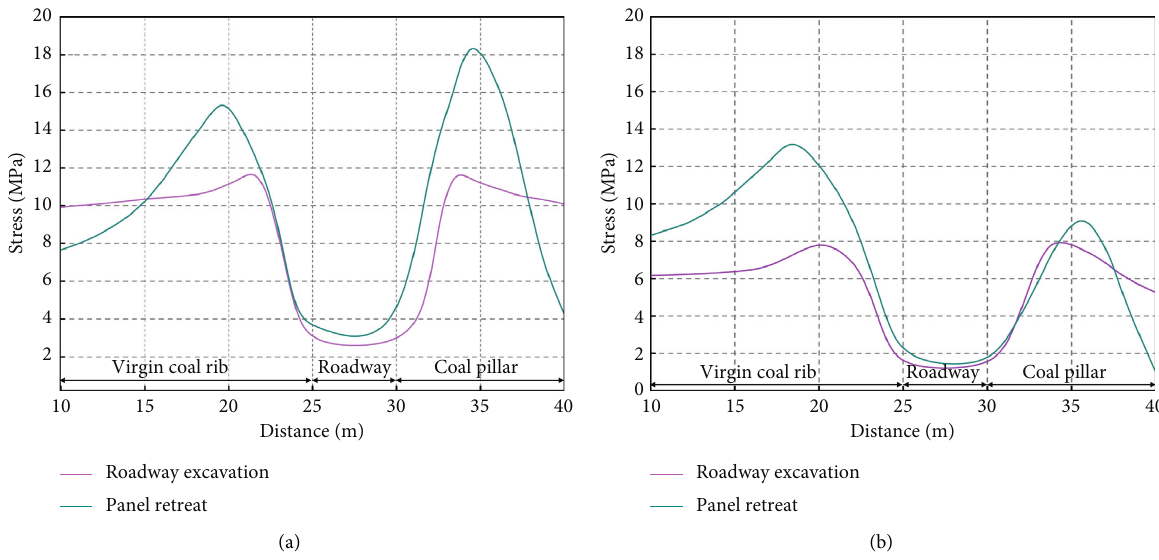
Figure 13: Vertical stress distribution of two roadway ribs at different stages. (a) Roof nonfracturing. (b) Roof